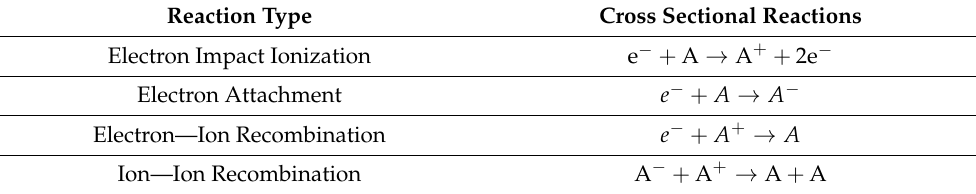
Table A3. Cross Sectional